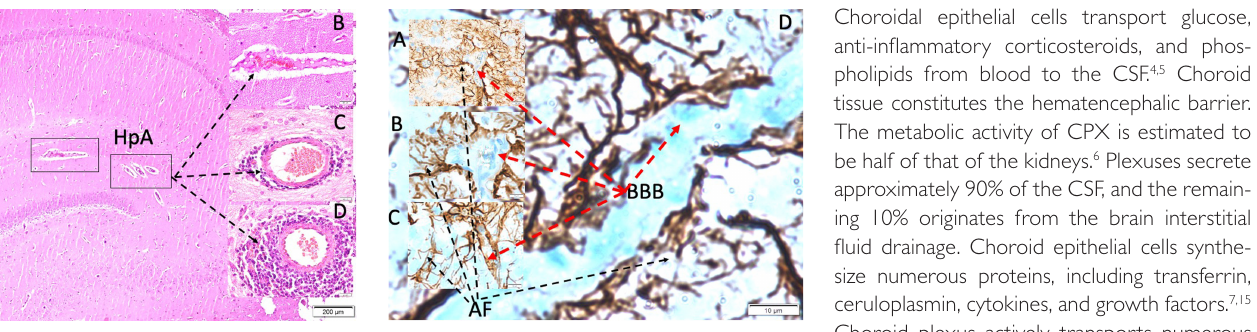
Figure 5. A normal blood–brain barrier formed by an artery with normal vascularity surrounded by dense astrocytes in the hippocampus is seen in the control group. In the sham group, a slightly narrowed artery and the blood–brain barrier with minimally fragmented astrocyte footpads are observed. In the study group, a large number of fragmented astrocytes and a blood–brain barrier with impaired wall integrity are